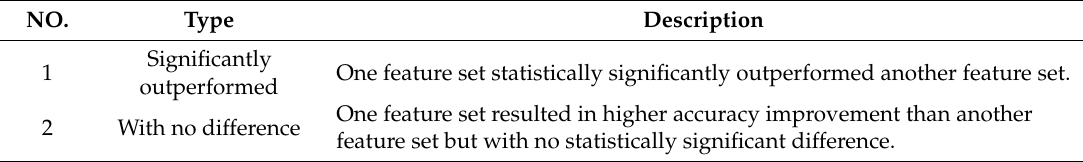
Table 15. Descriptions of the two defined relative importance grades between different feature sets in this